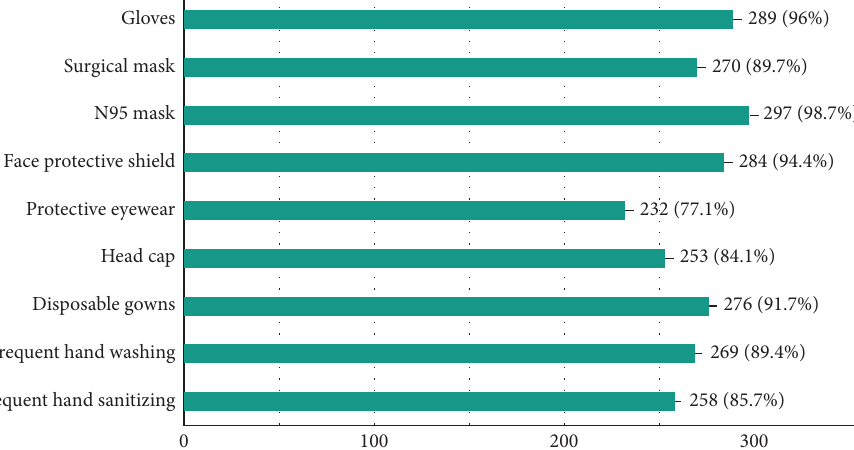
Figure 2: Availability and use of following measures will alleviate my concerns about treating patients in given times? (select all that apply) 301 responses.